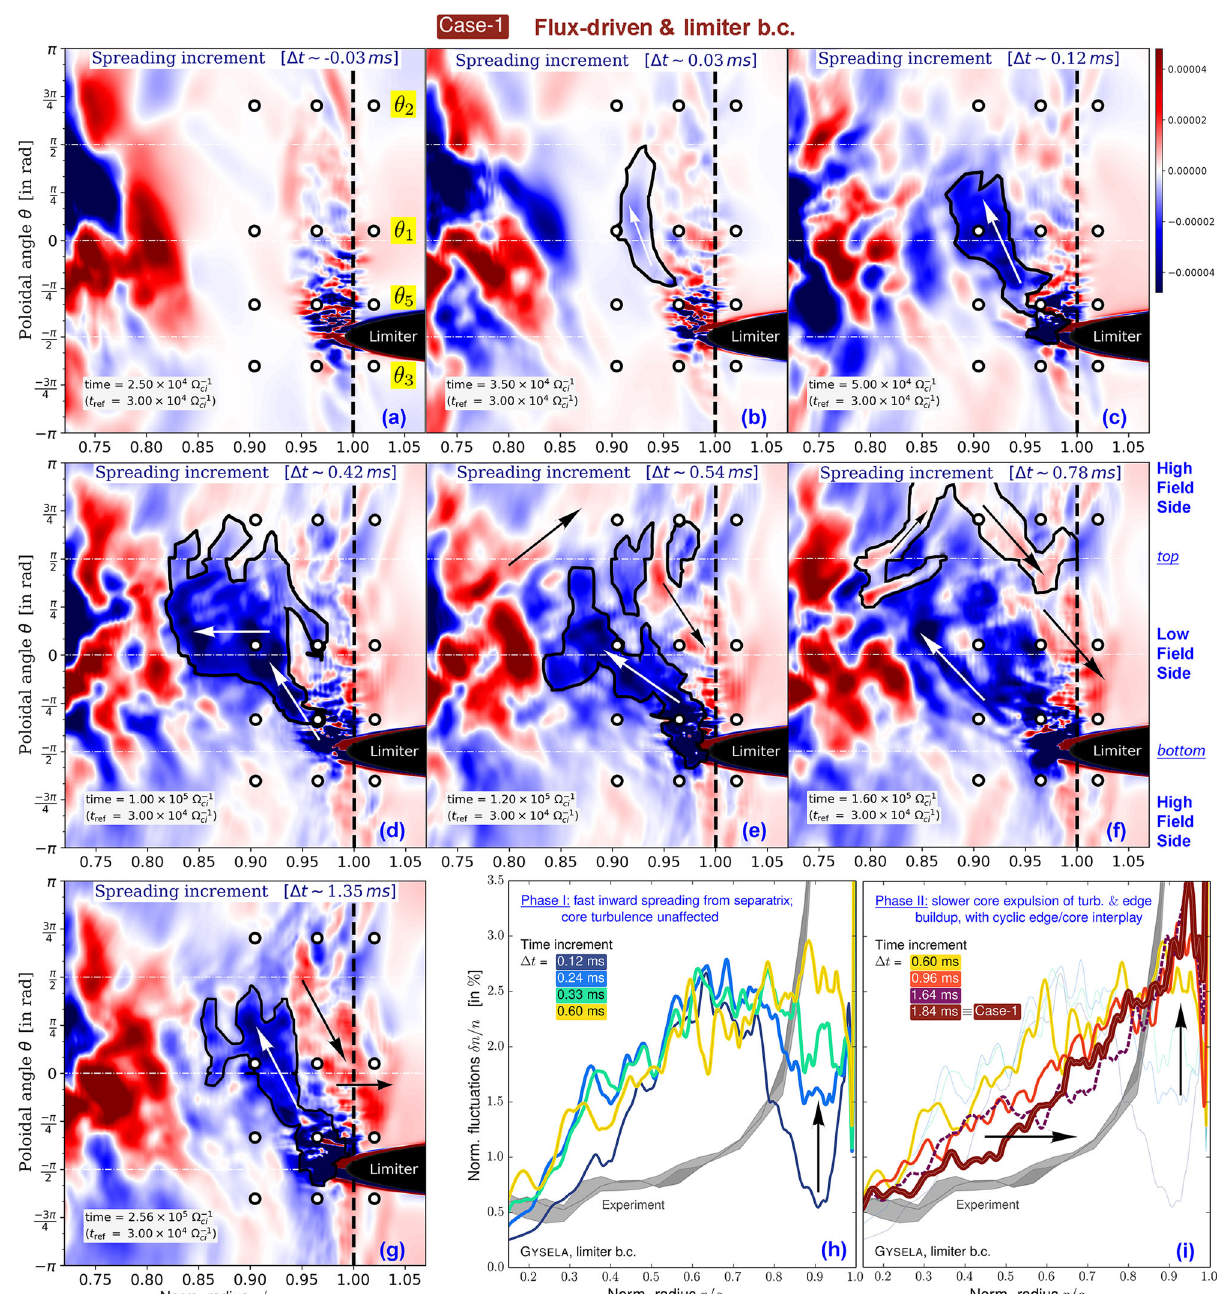
Fig. 3 Spatiotemporal redistribution of induced free energy injection at the plasma-boundary interface (for fl ux-driven Case-1). a – g times series of poloidal cross-sections of spreading increments Δ S . Positive (red) increments represent radially-outward fl uxes of turbulence intensity; inward fl uxes of turbulence intensity are pictured as negative (blue) increments. The limiter is responsible for vigorous mixing in its immediate poloidal (between θ 3 and θ 5 ) and radial (0.95 ≤ r / a ≤ 1.0) vicinity. The drive endures throughout linear ( a ) and nonlinear evolution [ b through g ]. The choice of an early reference time t ¼ 30 ; 000 Ω (cid:3) 1 t ci allows to follow the full unfolding of the spreading sequence in the edge. With a later choice for ref the early spreading sequence would ref not appear as clearly; later nonlinear dynamics (Phases II and III [ Δ t ≥ 0.6 ms]) on the other hand would be qualitatively unchanged: cyclic equilibration on the outboard midplane between incoming and outgoing fl uxes of turbulence intensity that originate from distinct poloidal regions. Inward spreading (Phase I, h ) is responsible for edge increase of turbulence activity at the outboard midplane. As ‘ No Man ’ s Land ’ (the region 0.85 ≤ r / a ≤ 1.0) fi lls-in, outgoing turbulence activity spreads to the edge [Phase II, i ], further enhancing relative fl uctuation levels in the outer edge. At equilibrium (Phase III, g ), the fl uctuation pro fi le hovers about its 1.84 ms value ( i ) equilibrating incoming and outgoing spreading and reaching equilibrium in ~0.6 ms. A clear shortfall is observed (core or boundary) regions. Spreading in gradient-driven Case-3 is [Fig. 4c, top] past 0.85 ≤ r / a for Case-2 and past 0.8 ≤ r / a for Case- modest, at most about a few local turbulence correlation lengths, as 3, again reminiscent of linear stability of underlying gradients, in earlier works 28 , and insuf fi cient to explain the required fl uctuation levels both in the deep core and in the edge. uncompensated by fl uxes of turbulence activity from distant active